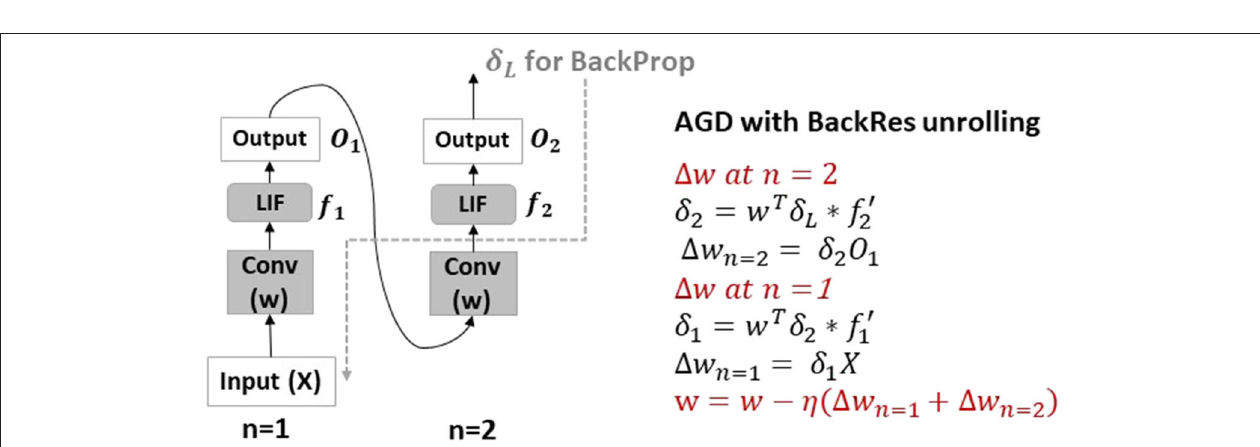
FIGURE 4 | Conversion of ANN with BackRes blocks into SNNs using threshold balancing. Here, during BackRes computations, we need to use multiple threshold v thresh IF neurons IF 1 , IF 2 to match the input-output activity between ANN and SNN at each unrolling step n = 1,2. 1,2